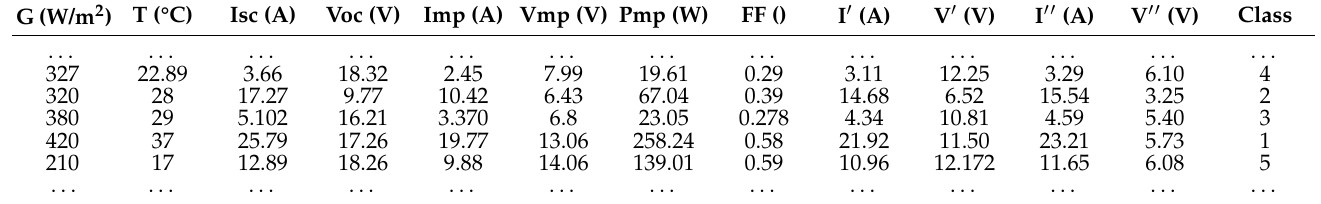
Table 2. Extracted features from the I–V characteristics with labeled classes at various working